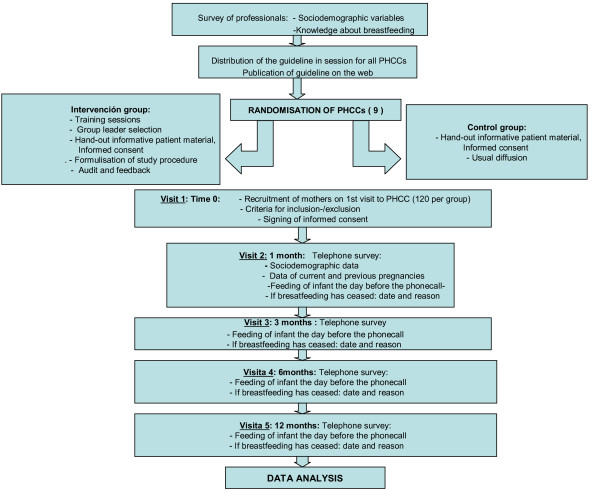
Project structure.